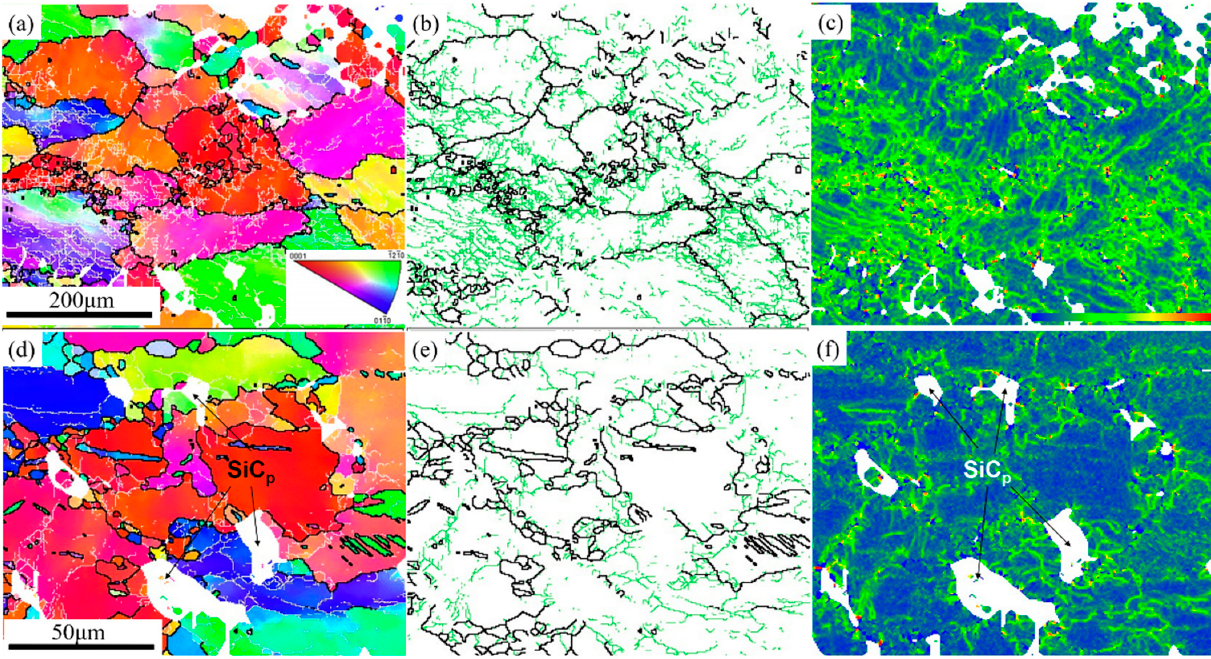
Figure 7. EBSD results of the SiC p /Mg-5Zn material with a compression strain of 0.1: ( a , d ) IPF maps, ( b , e ) grain boundaries distribution maps and ( c , f ) KAM map.